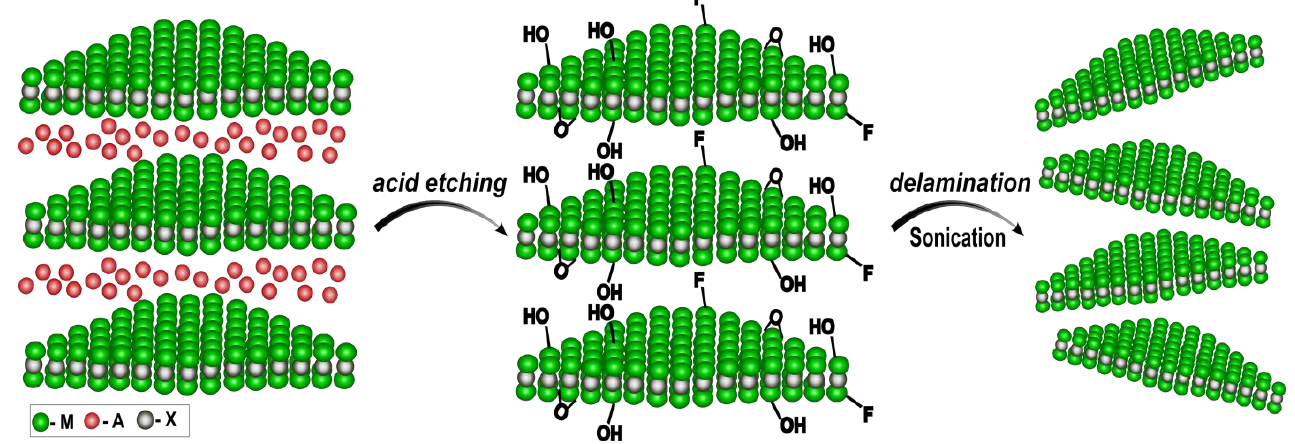
Figure 9. Preparation of MXenes by etching the A metal from the MAX phase, followed by exfoliation of the layers through sonication.